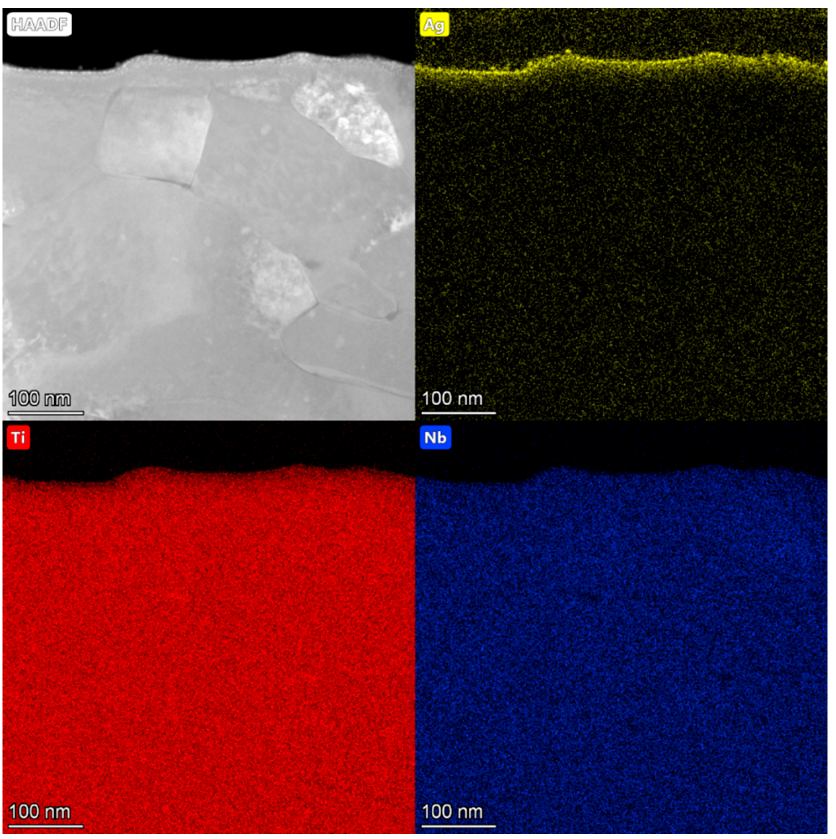
Figure 6. TEM image of the cross section for Ag-implanted layer and the mapping images of the contained elements (Ti, Nb, and Ag elements).